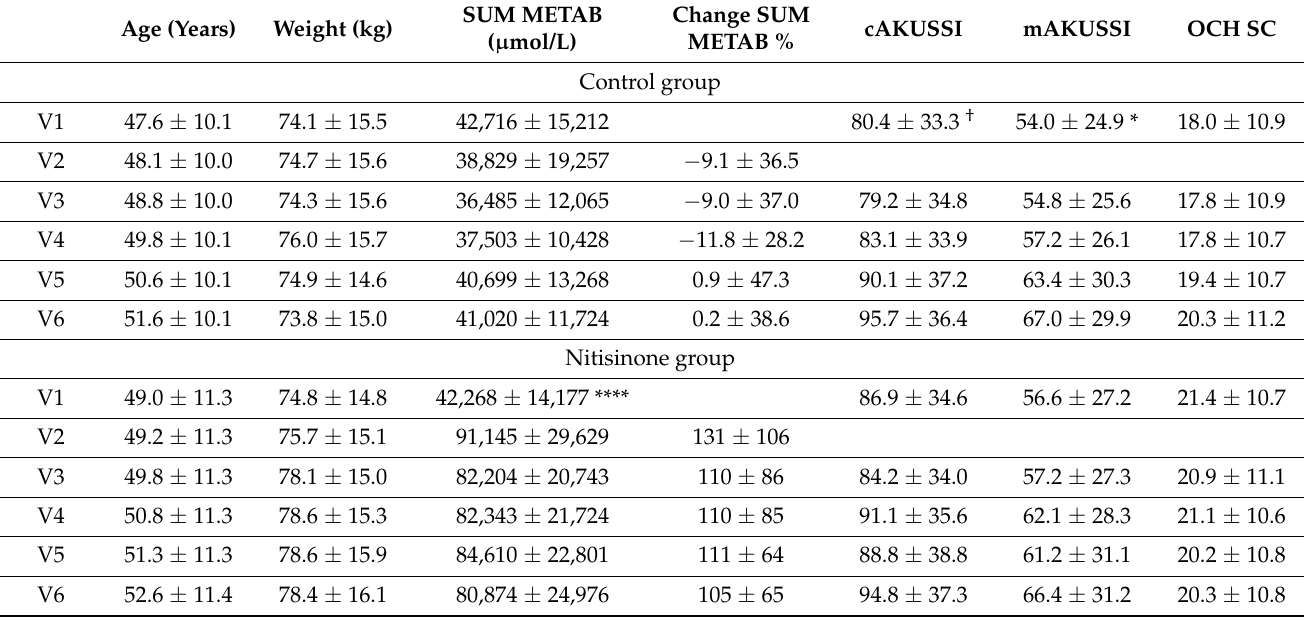
Table 1. Details of SUM METAB (TBW + URINE) in control (n = 69) and nitisinone-treated (n = 69) groups in the combined female and male